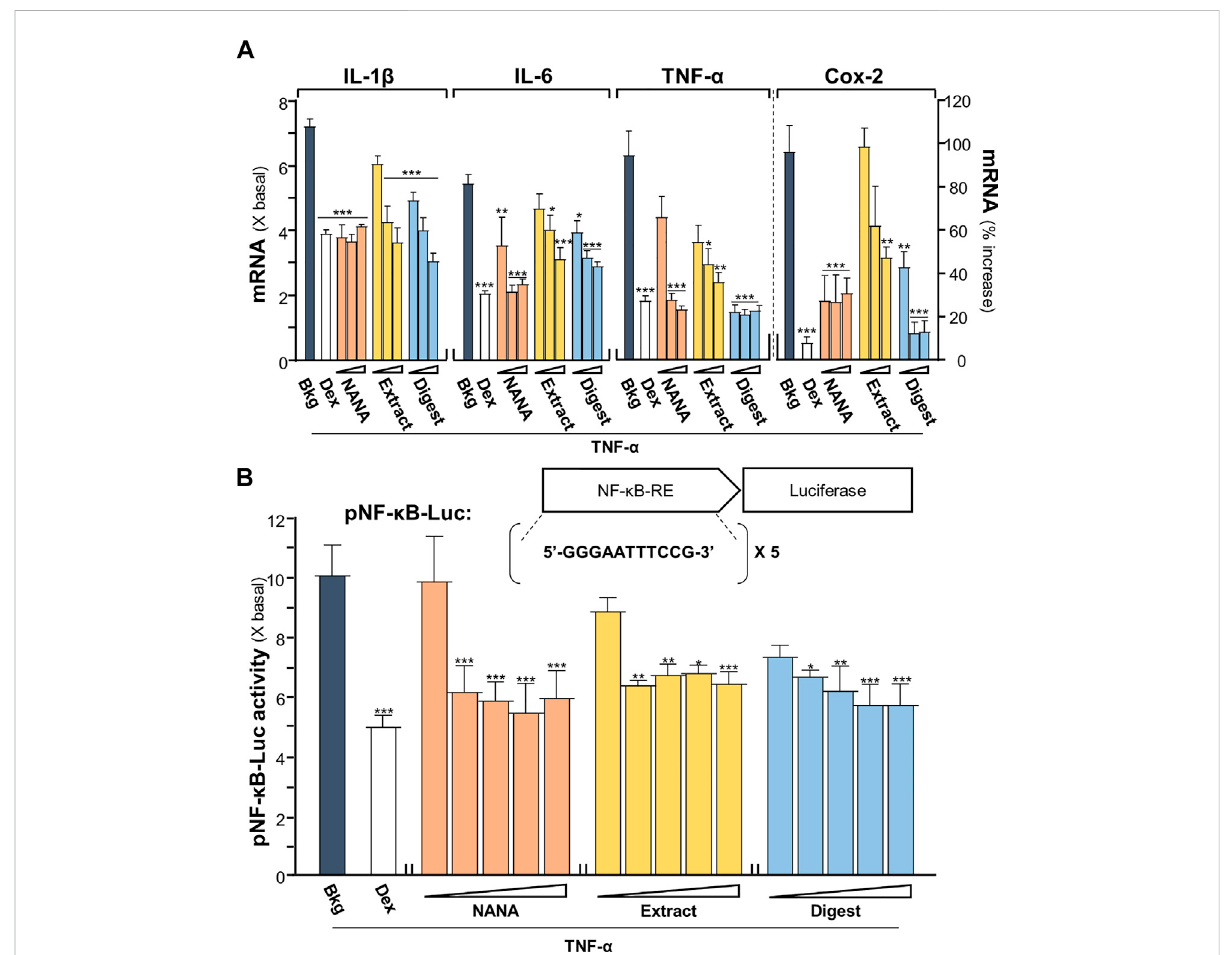
FIGURE 1 EBNreducestheTNF- α -inducedin fl ammatoryresponses. (A) ThemRNAlevelsofIL-1 β ,IL-6,TNF- α andCox-2inculturedHaCaTkeratinocytes after 2-h co-treatment of TNF- α (20 ng/mL) and EBN preparations are shown. NANA (0.05, 0.1, 1 mM), and EBN extract or digest (1, 10, 100 μ g/mL) were applied, as indicated. Dexamethasone at 10 nM was a positive control. (B) The pNF- κ B-Luc plasmid, composed of 5 NF- κ B response elements tagged with fi re fl y luciferase reporter, was transfected into keratinocytes for 24 h, followed by TNF- α (20 ng/mL) stimulation and EBN incubationfor2 h.ThedoseswereNANA(0.01,0.05,0.1,0.5,1 mM),andEBNextractordigest(1,5,10,50,100 μ g/mL).Theluciferaseactivityofeach well was normalized to total protein. The values are expressed, except Cox-2 mRNA level shown in percentage of increase, as the fold change to normalized basal activity set at 1, in mean ± SEM, n = 6. Statistically signi fi cant results are marked with * p < 0.05, ** p < 0.01 and *** p < 0.001 against the TNF- α -treated